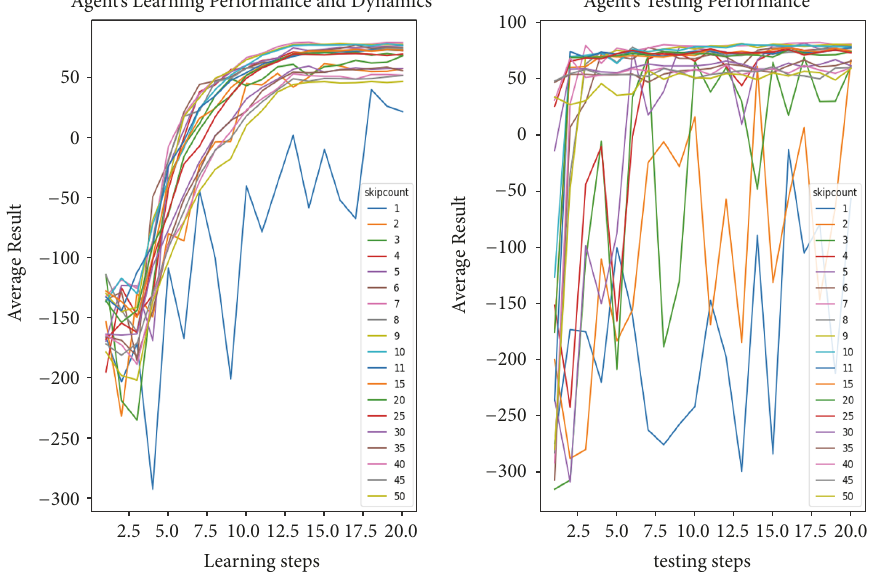
Figure 4: Showing the agent learning and testing performance for 19 different skip